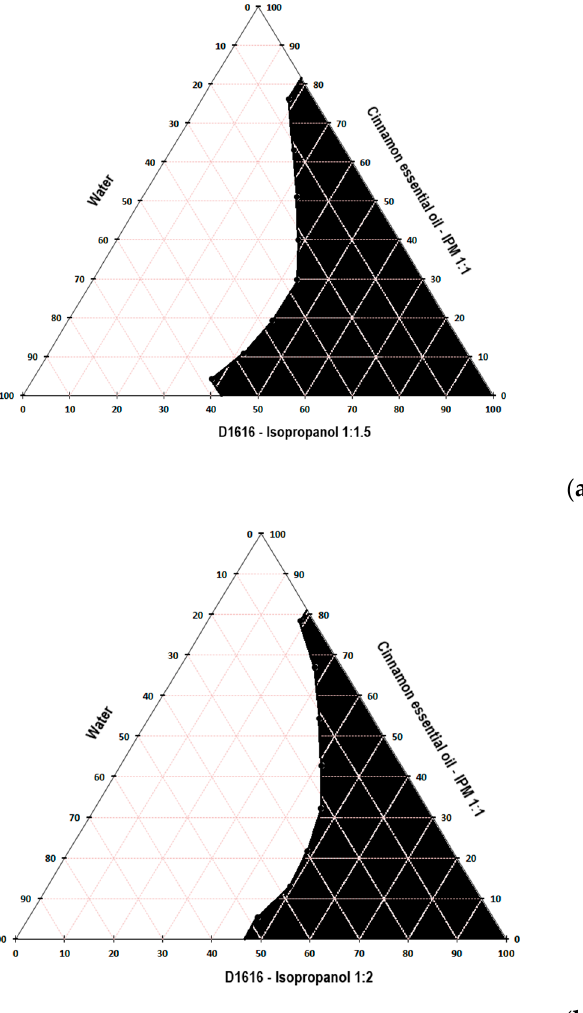
Figure 2. Pseudo-ternary phase diagram for the clove essential oil/IPM– D1616/IPA –water system, for S mix ratio 1:2.